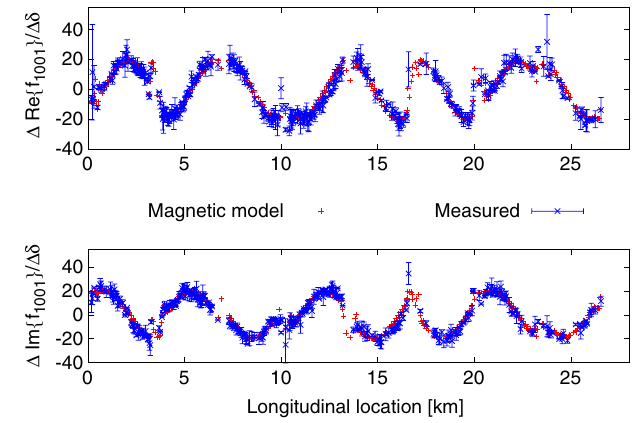
FIG. 1. Top: quadrupoles and skew sextupoles in the LHC arc. There are four skew sextupoles installed in each arc to correct for the chromatic coupling, shown as green bars. The horizontal axis shows the distance from ATLAS, so this is in the middle of the arc. Bottom: (cid:1) functions and horizontal dispersion. The phase advance between each FODO cell is approximately 90 (cid:4)